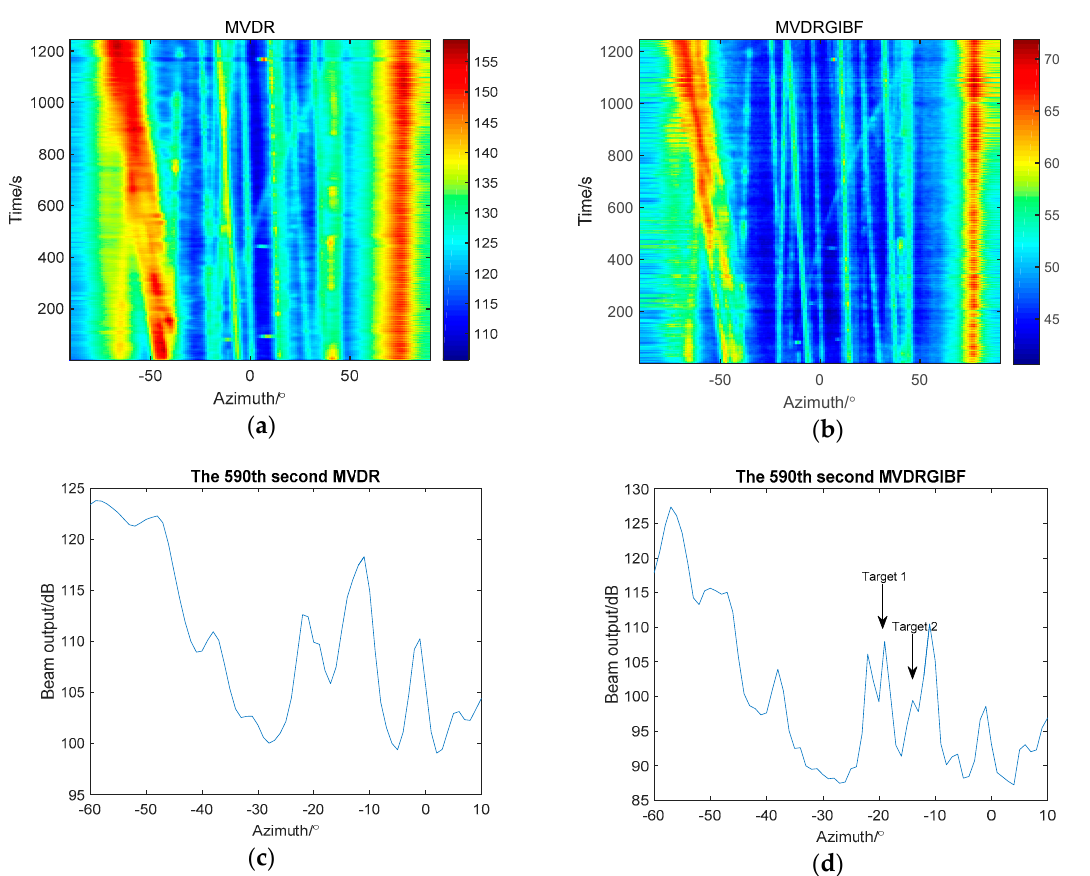
Figure 9. Comparison between applying MVDR (minimum variance distortionless signal response) and combination of MVDR and GIBF: ( a ) azimuth history diagram processed by MVDR; ( b ) azimuth history diagram processed by MVDR and GIBF ( c ) the 590th s results processed by MVDR; ( d ) the 590th s results processed MVDR and